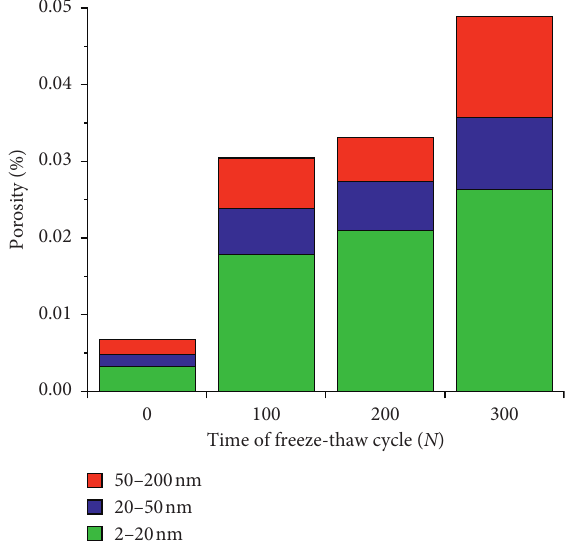
Figure 7: Pore size distribution of the